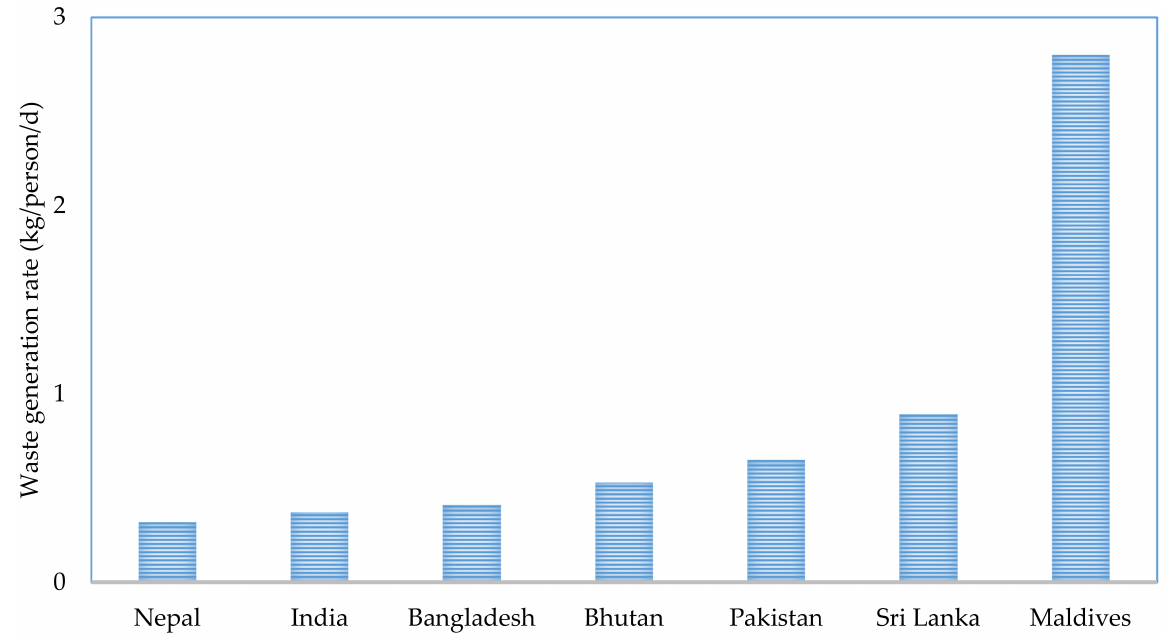
Figure 2. Per person MSW generation of South Asian countries.